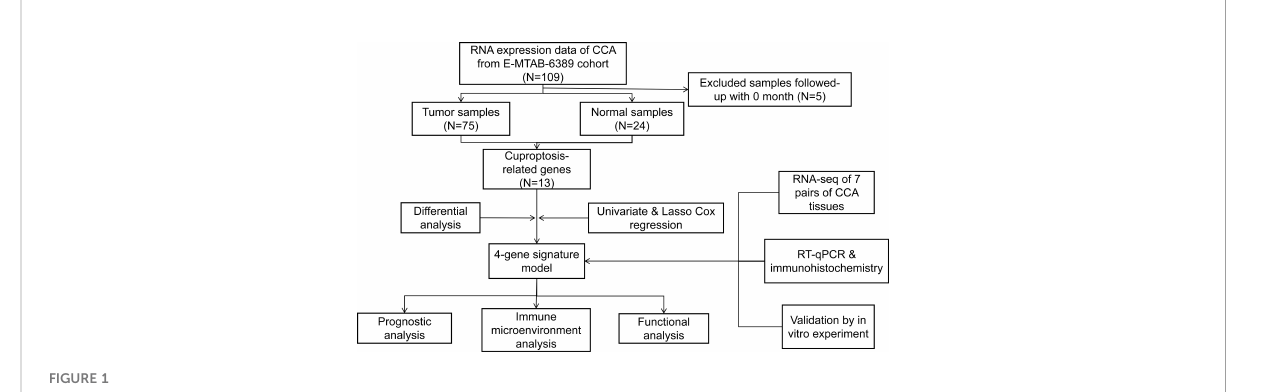
FIGURE 1 Flowchart of the entire analytical process.